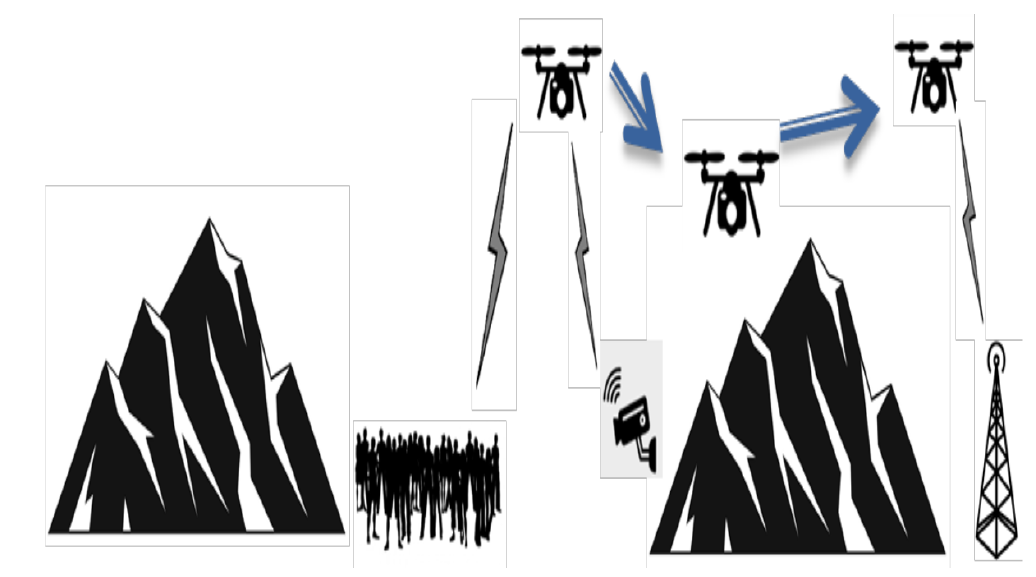
Figure 2. A practical scenario where UAVs act as relay stations